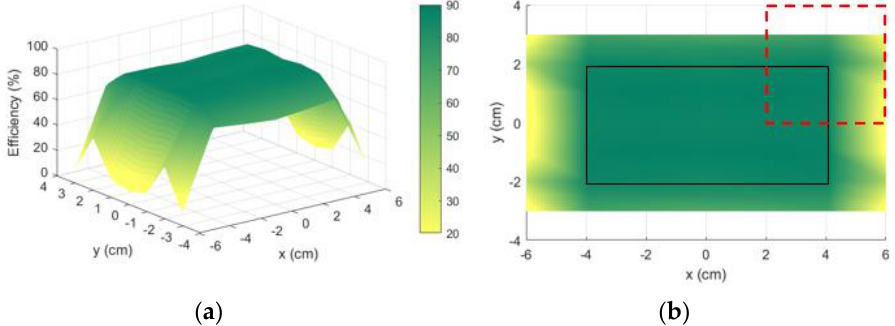
Figure 15. Efficiency measurements for a fixed load of 50 Ω with the input always adapted to 50 Ω : ( a ) 3D plot of efficiency vs. the x and y axes; ( b ) 2D plot of the efficiency seen from the top. The coordinates x and y represent the center position of the receiver. The dashed line represents the Rx contour in an extreme position (its “center” is located at x = 4 cm and y = − 2 cm).